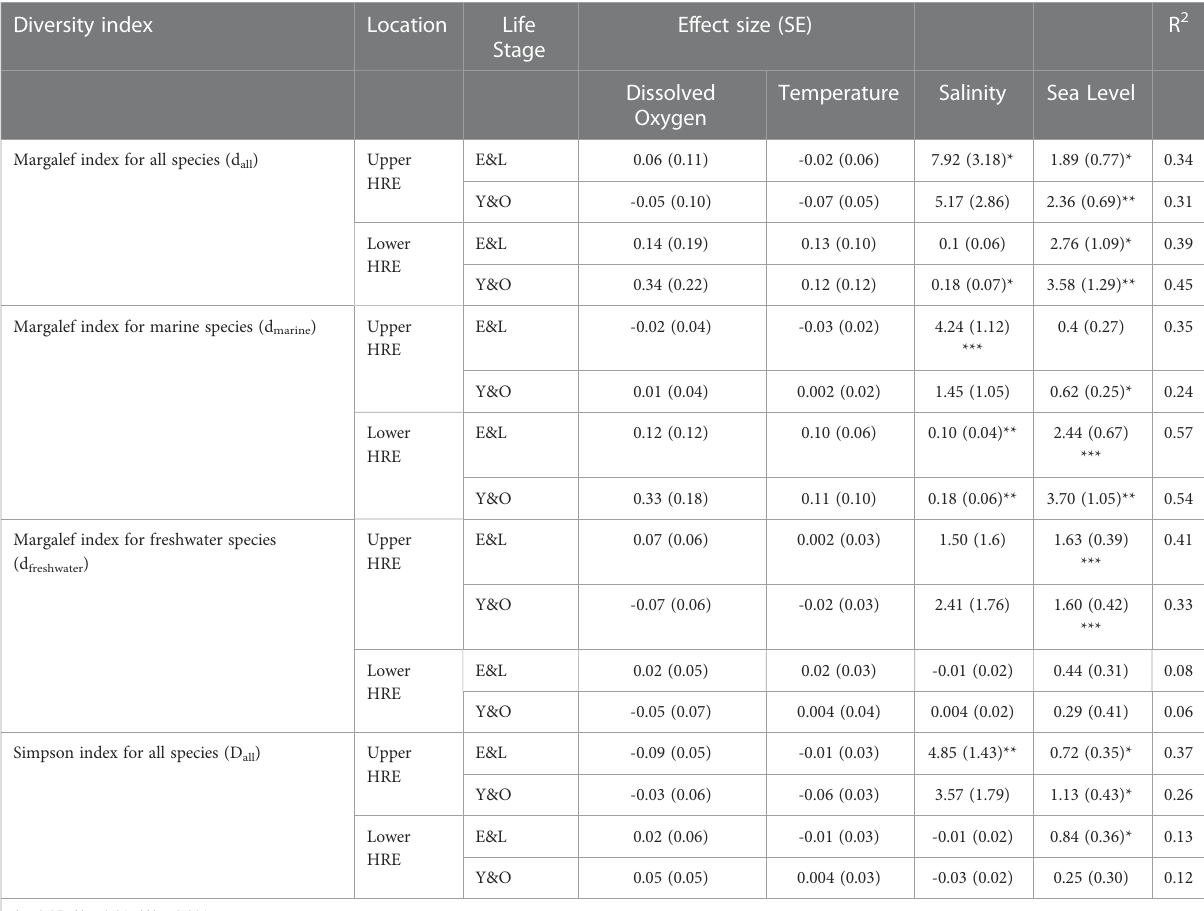
TABLE 2 Model statistics from the linear models for factors associated with Margalef and Simpson indices for the early (eggs and larva; E&L) and older (young-of-year [YOY] and older; Y&O) life stages in the lower and upper Hudson River Estuary (HRE) during May-July from